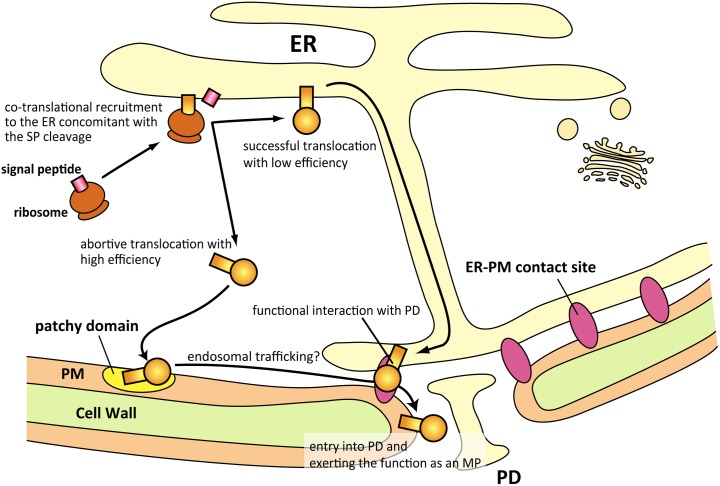
A model for the intracellular trafficking of MPFMV.